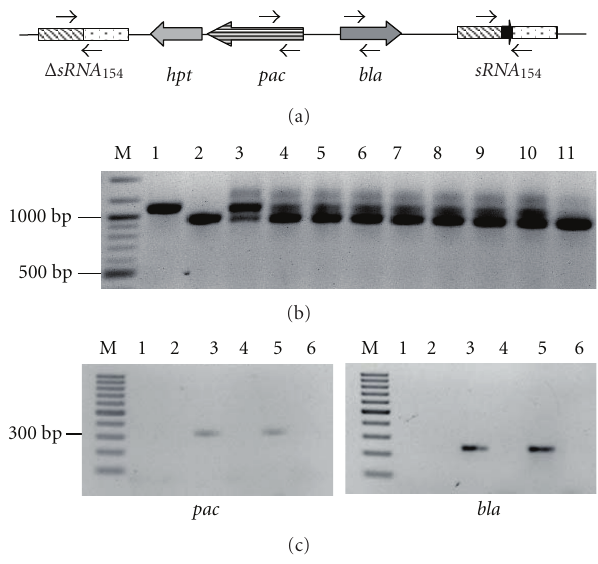
Figure 2: Verification of Δ sRNA 154 strains by PCR. (a) Cartoon of plasmid pRS623 integration into the M. mazei chromosome. Primers for PCR verification are shown by arrows (sizes do not correspond to actual proportions). (b) M. mazei wild-type and mutant strains Δ sRNA 154 , Δ hpt, and a diploid strain with pRS632 integrated into the chromosome were tested by PCR analysis for presence of the sRNA 154 gene and Δ sRNA 154 deletion construct.